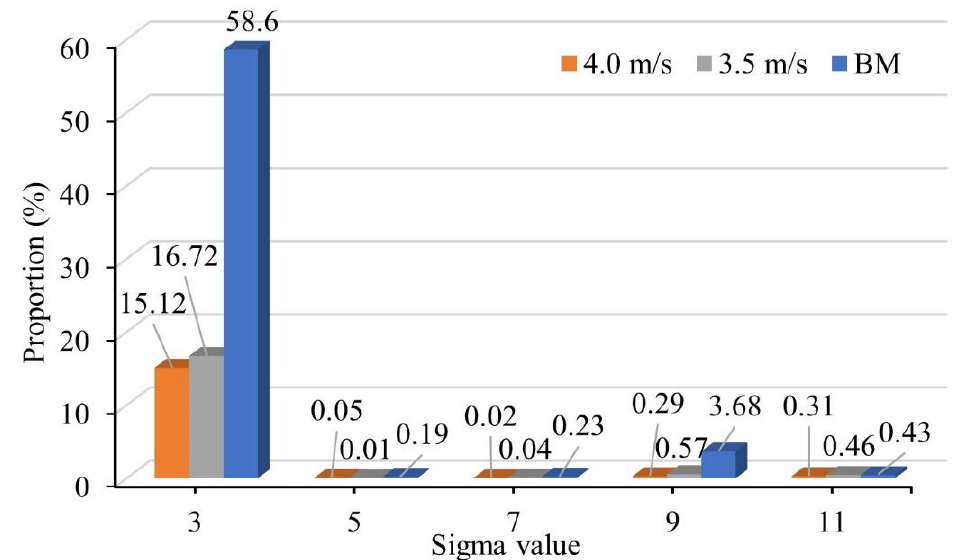
Figure 11. Distribution characteristics of CSL grain boundaries in the BM and WM under different welding speeds.